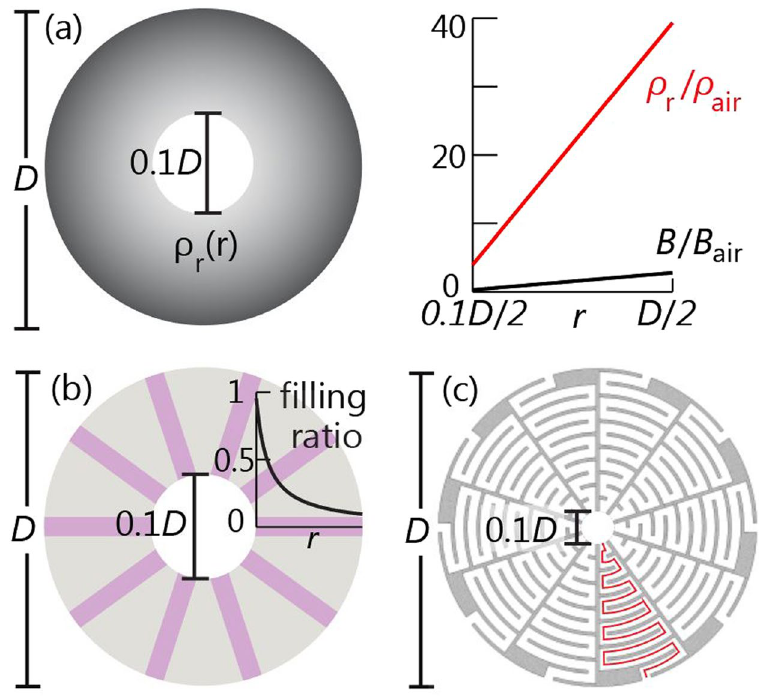
Figure 4. ( a ) An abstract medium (left panel) with inner and outer diameters 0.1 D and D has an infinite azimuthal density ρ θ and a constant radial sound speed lower than the sound speed of air ( c r << c air ). It has radially dependent radial density ρ r and bulk modulus B , as shown in the right panel. ( b ) The preliminary equivalent model made of rigid materials (gray) with straight channels (purple) has the radially varying filling ratio. ( c ) The enclosure made of rigid materials (gray) has air-filled channels with coiled sound paths (red